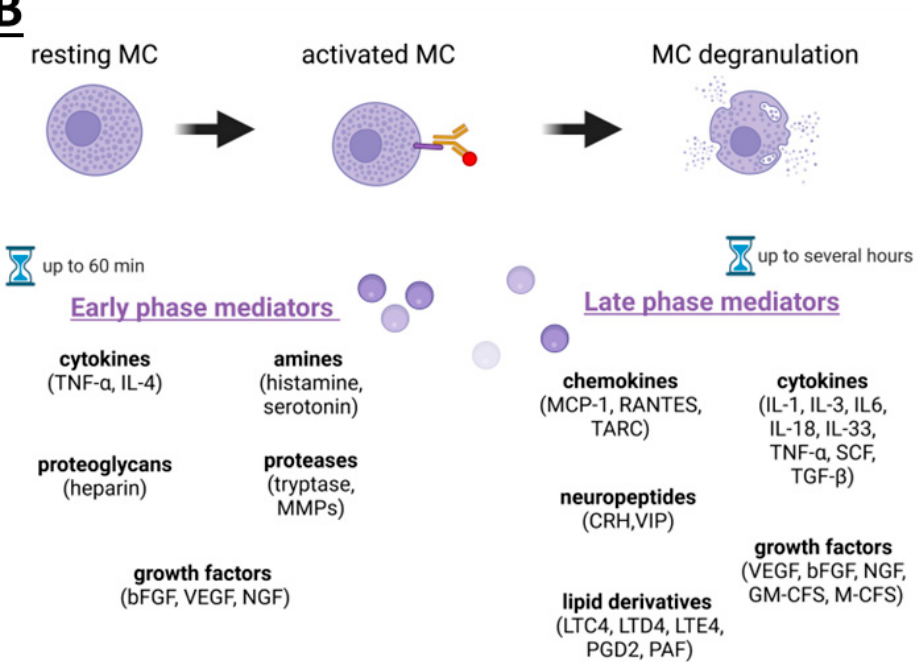
Figure 1. Several types of receptors and coreceptors are present on the mast cell surface ( A ) and upon MCs activation, various mediators of the early and late phases are released ( B ). Figure created with BioRender.com.